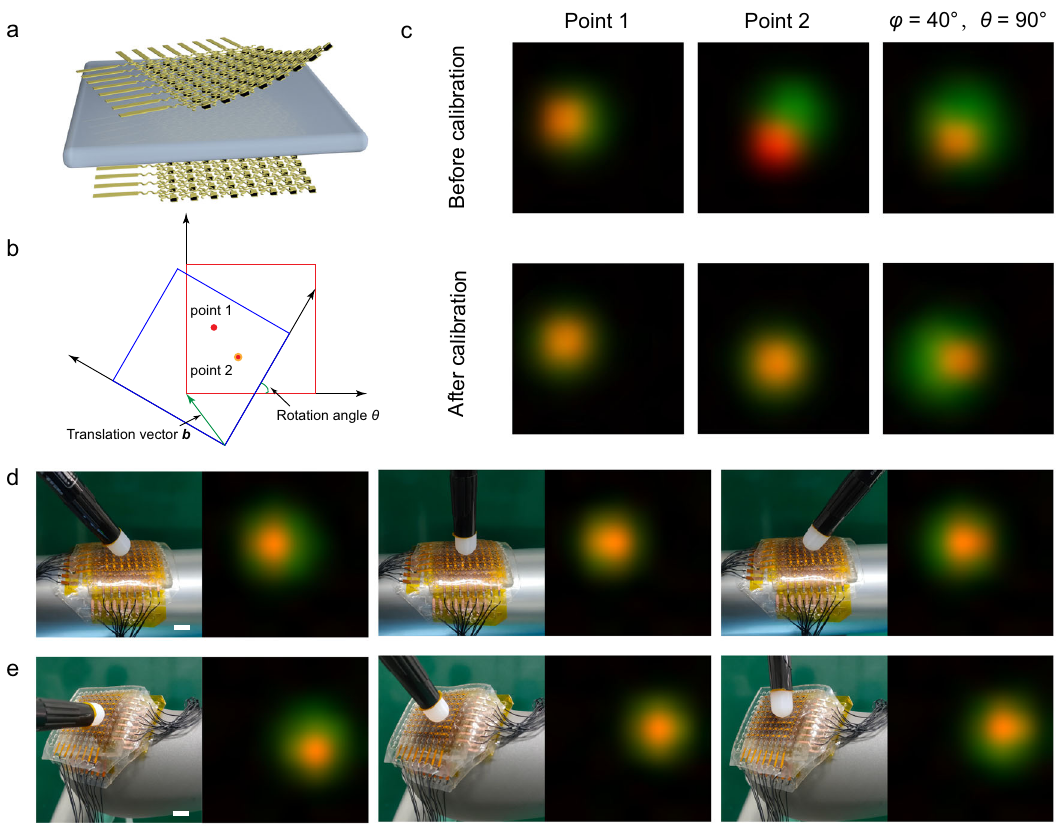
Fig. 5 Demonstration of the modularity of BMRs and its application on curved surface. a Illustration of random orientation of epidermal and dermal sensor arrays. In a real usage case, the epidermal and dermal sensing array may be misaligned due to assembly error or fatigue. b Schematic diagram of the misaligned model and the correction points. Point 1 and point 2 are arbitrary test points. c Before and after calibration of the force data for test points 1, 2 and an applied 3D force at φ = 40°, θ = 90°. d , e 3D force measurement from the BMRs attached on the curved surfaces of robotic arm and elbow. Scale bar: 1 cm ( d , e